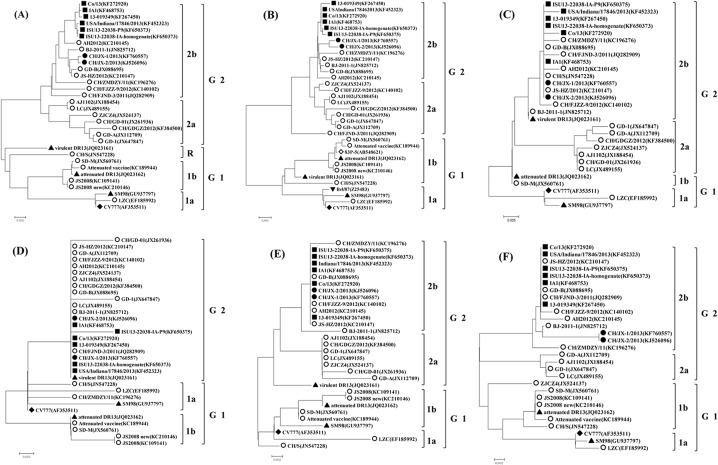
Phylogenetic trees based on the complete genome, aa sequences of structural proteins and ORF3 of PEDV strains.The trees were constructed by the distance-based neighbor-joining algorithm using MEGA 5.2.2 software. Bootstrap was set in 1,000 replicates with a value >70% to assess the significance of the tree topology. A bar of 0.002/0.005 indicates nucleotide or amino acid substitutions per site. “●” indicates the strains identified in this study, “○” indicates the strains from China, “◆” indicates the strains from Belgium, “■”indicates the strains from USA, “▲”indicates the strains from South Korea, “▼”indicates the strains from France, “◇”indicates the strains from Japan. 1A: Phylogenetic tree generated on the basis of nucleotide sequences of the complete genome of 33 PEDVs. 1B to 1F: Phylogenetic trees based on deduced amino acid sequences of S glycoprotein genes, ORF3, envelope, membrane, and nucleocapsid genes, respectively.